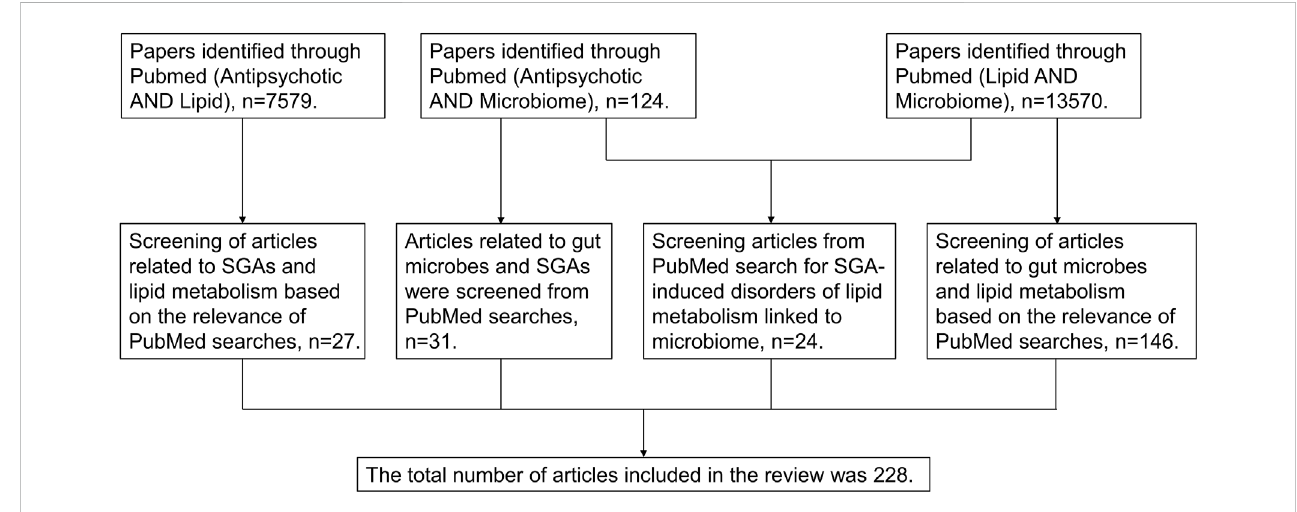
FIGURE 1 Flow chart diagram delineating search method.